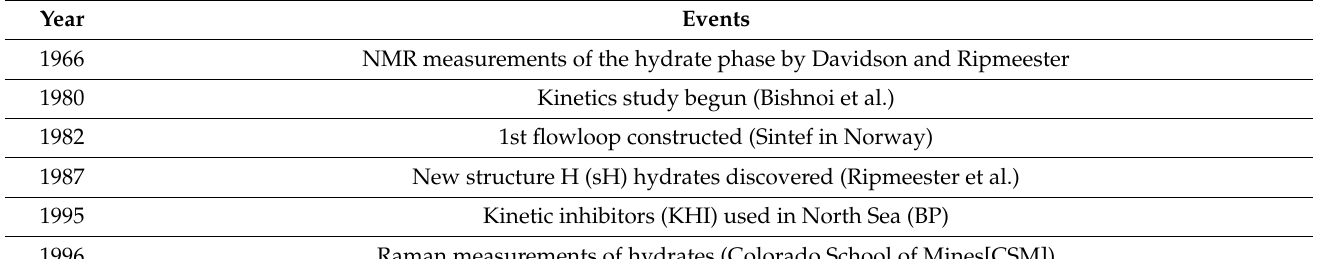
Table 2. Modern hydrate flow assurance